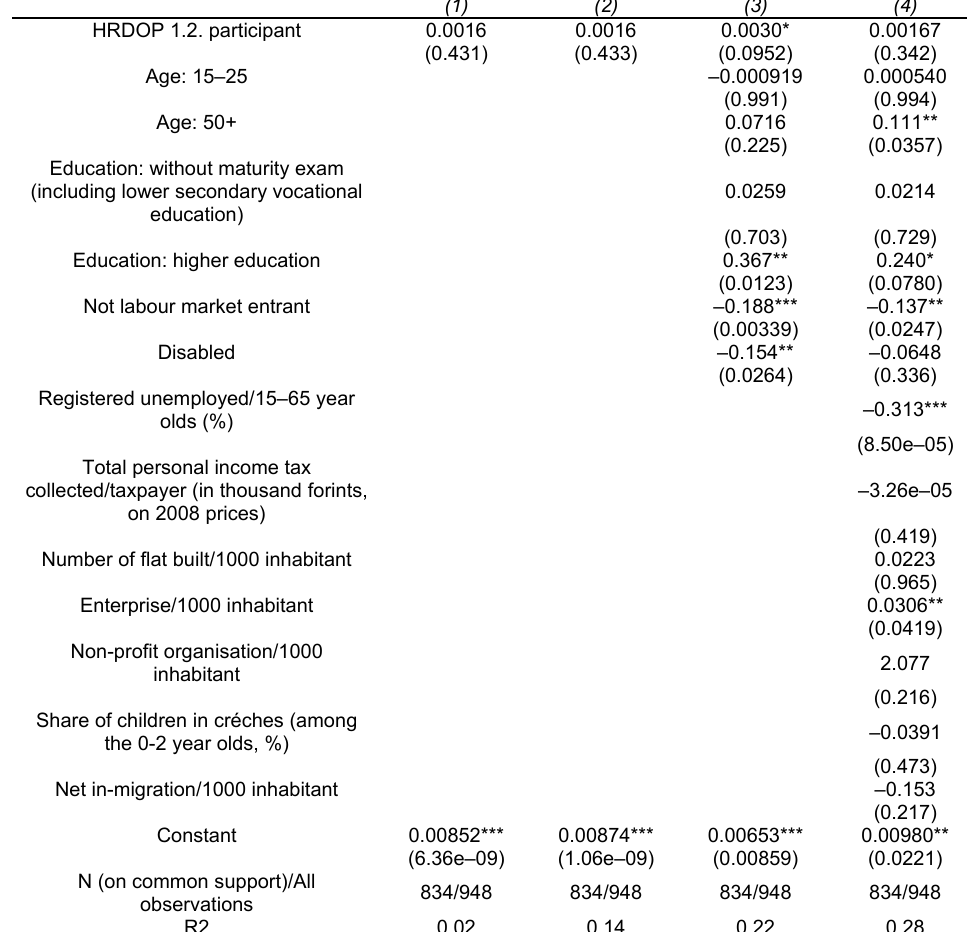
Table 3: Results from DiD OLS regressions in various specifications